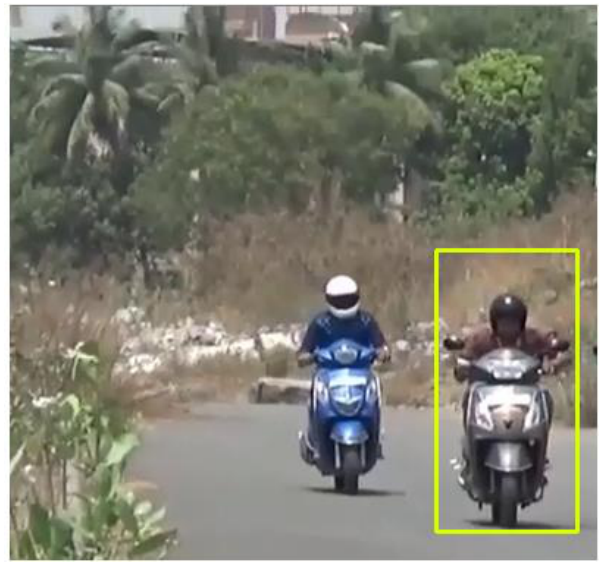
Figure 6. When user selects bike detection (ref. Figure